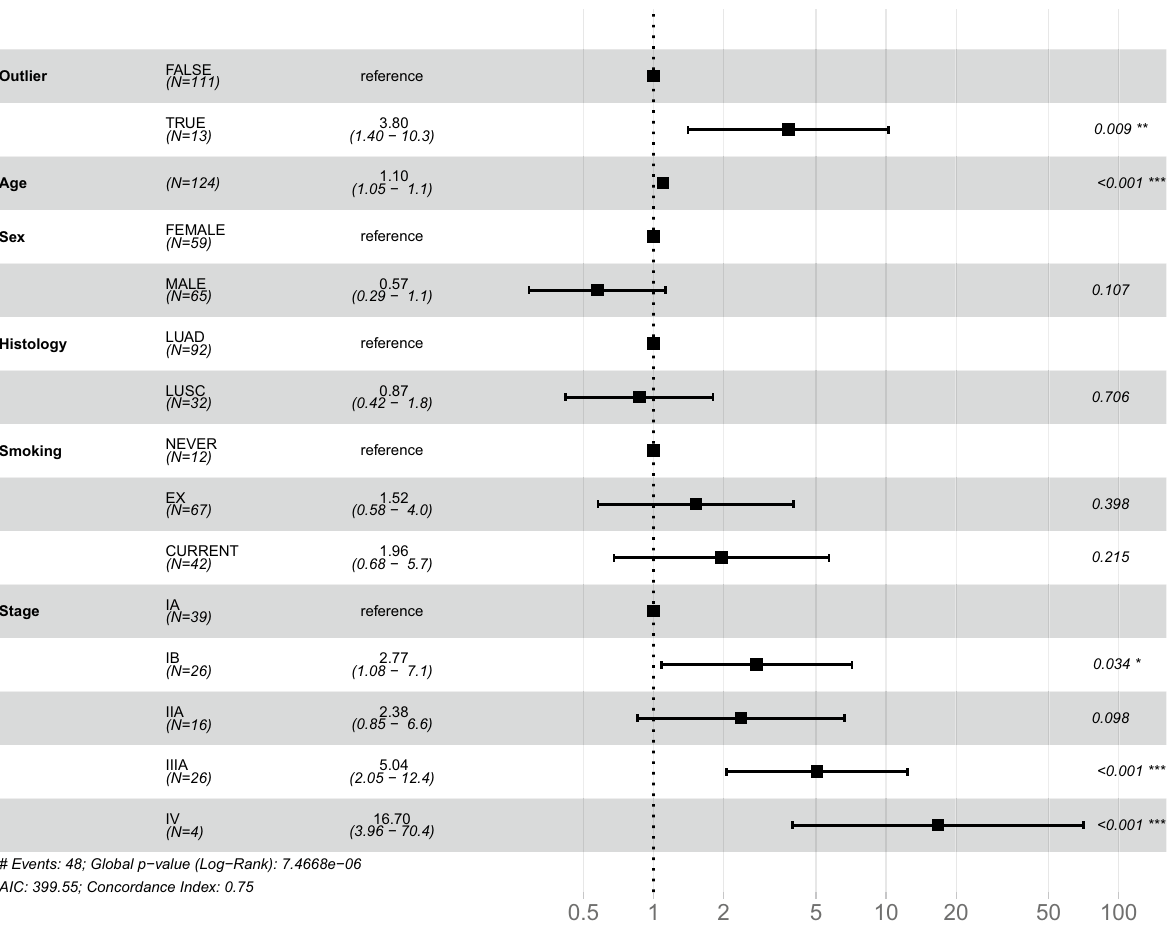
Figure 4. Forest plot for Cox proportional hazards model. The figure provides a forest plot reporting the hazard ratio (HR) and the 95% confidence intervals of the HR for each covariate included in the Cox proportional hazards model. The variable Outlier specifies male tumour samples showing relative KDM5D deficiency (≥ 1.5 SD below the overall male mean). Magnitude of significance is denoted with asterisks (*). LUAD lung adenocarcinoma, LUSC lung squamous cell carcinoma, AIC Akaike information